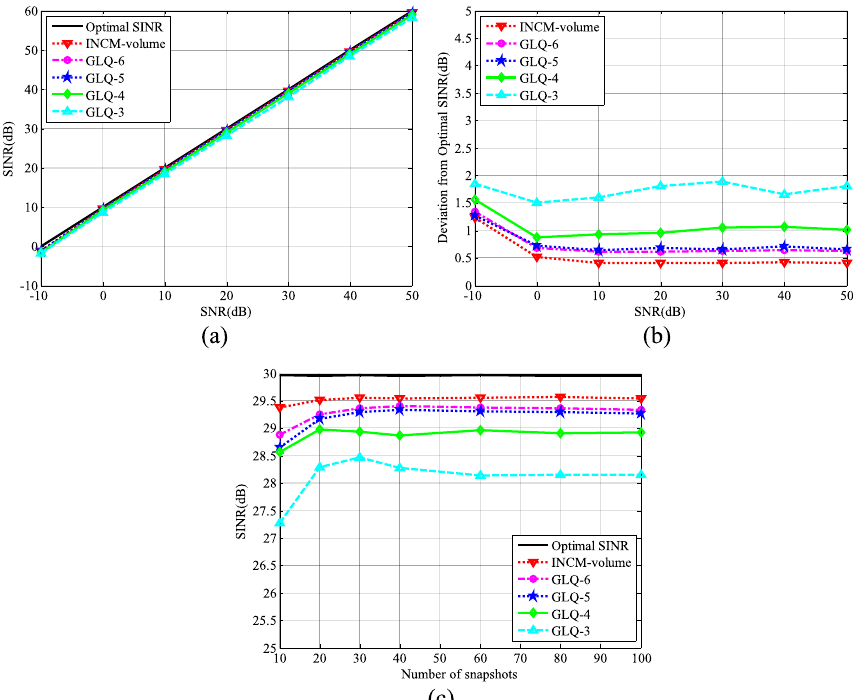
Fig. 4 Comparison of SINR. a SINR versus SNR. b Deviation against SNR. c SINR against number of